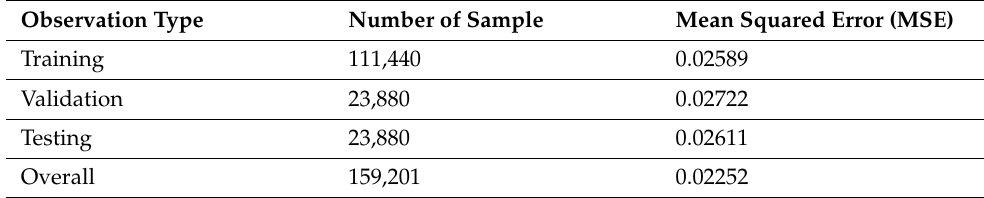
Figure 8. ( a ) Validation performance of proposed system. ( b ) NARX method histogram MSE. Table 4. Training Outcomes by Means of Proposed NARX Controller. Table 4. Training Outcomes by Means of Proposed NARX Controller.